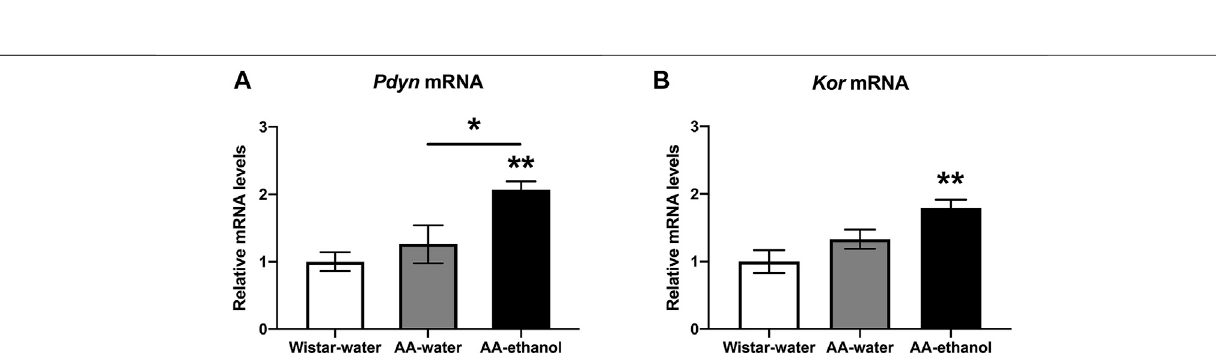
Frontiers in Genetics |